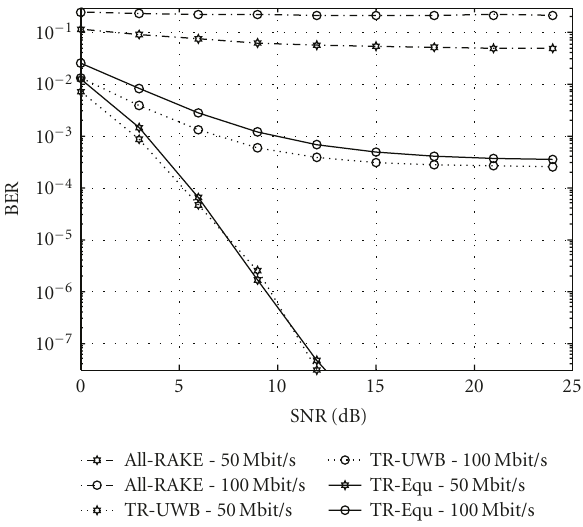
Figure 10: BER curves for ISI and MUI for Reed-Solomon coding at 30Mbit/s, N s = 5.